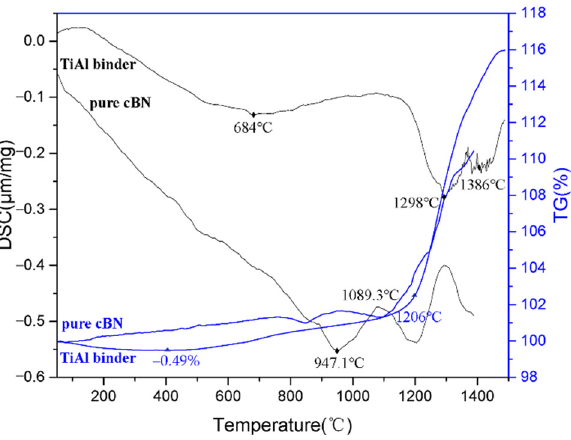
Figure 7. TG-DSC curves of the cBN composite (15 μ m) and pure cBN abrasives.